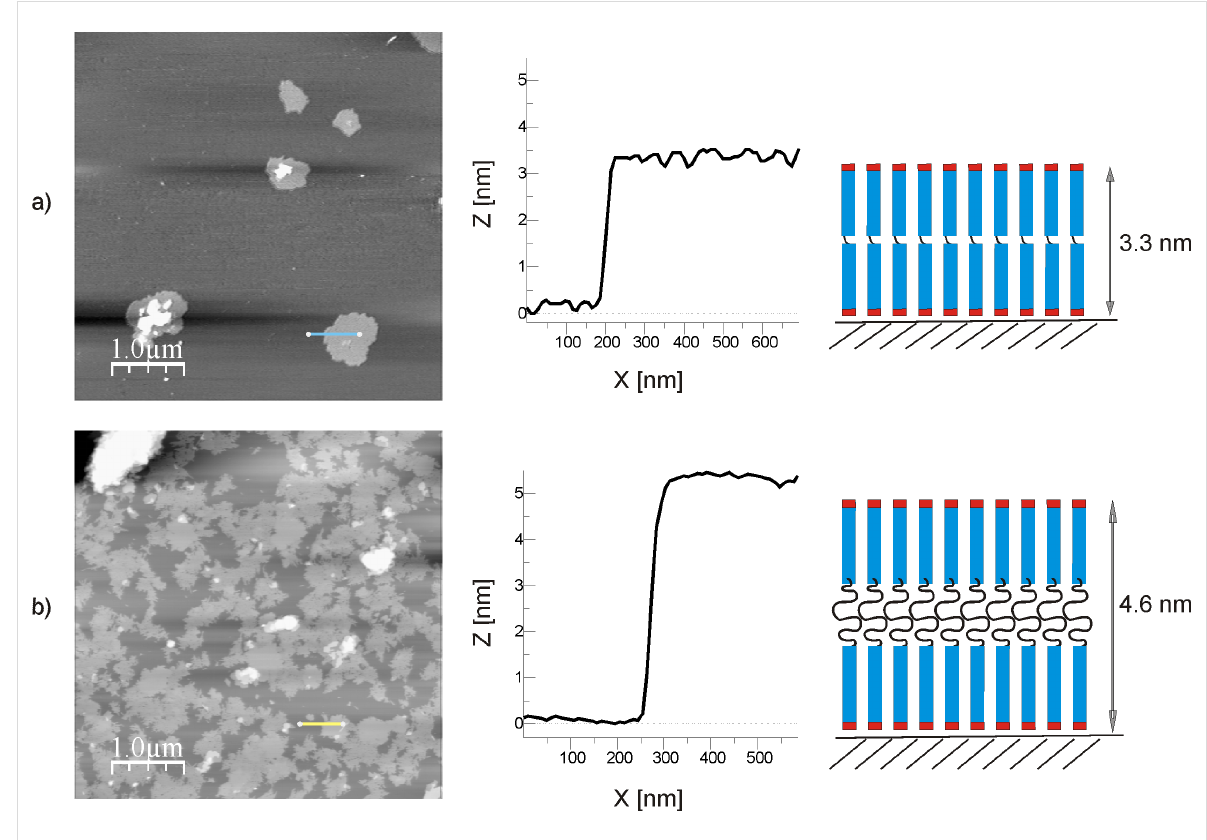
Figure 7: SFM images of associates formed by peptides а ) Н -Gly 5 -NH( СН 2 ) 2 NH-Gly 5 - Н and b) Н -Gly 5 -NH( СН 2 ) 10 NH-Gly 5 - Н (concentration 0.1 mg/mL) on a mica surface at рН 6.5 with t е xp = 10 min SFM tapping mode in air, and an incubation time in solution of 1 min. Surface profiles, schematic layer models, and their calculated heights are given on the right.